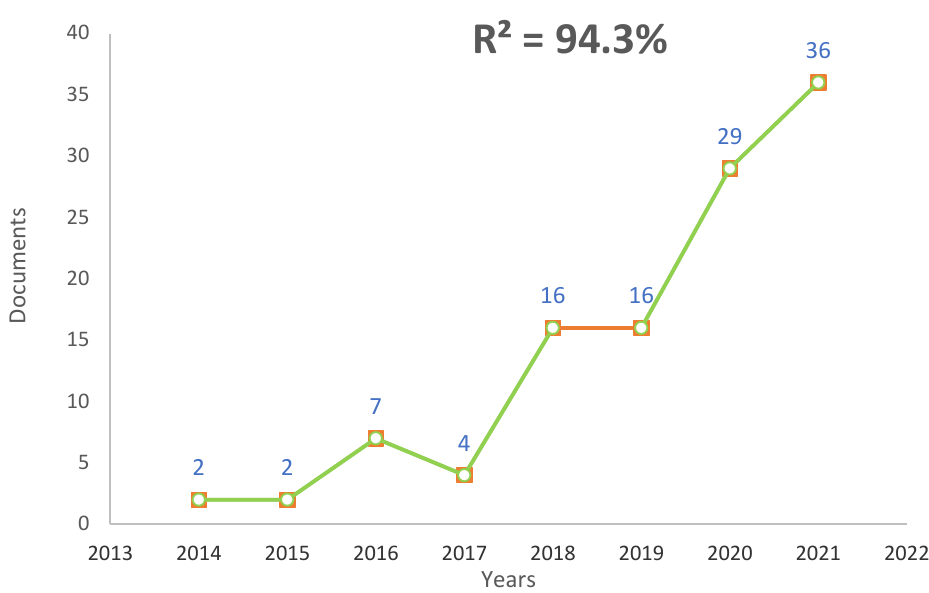
Figure 1. Annual publication trends regarding physical literacy.